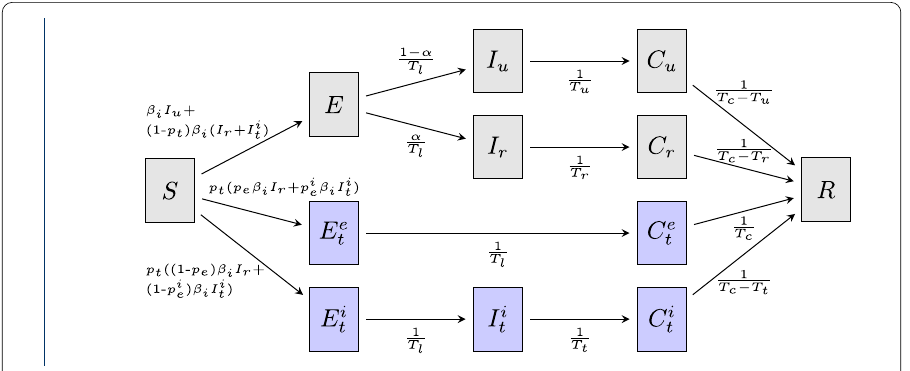
Figure 15 Structure of the compartmental model. The model is based on a SEIR-type model from Ref. [58] and is extended with a convalescing ( C ) compartment. A person in the convalescing compartment is technically still infectious, but the chance to infect further is drastically reduced, as this person is either isolated or the viral load is too low. The sum of the specific infectious periods is given by T con . Untraced compartments are indicated in gray and traced compartments in blue. See Table 3 for the definitions of the